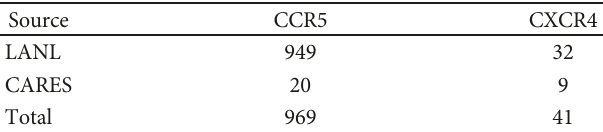
Table 1: Identi fi cation of HIV-1 Vpr sequences colinear to Env-V3 sequences de fi ned as R5 or X4. A total of 1010 Vpr sequences were classi fi ed according to coreceptor utilization using WebPSSM